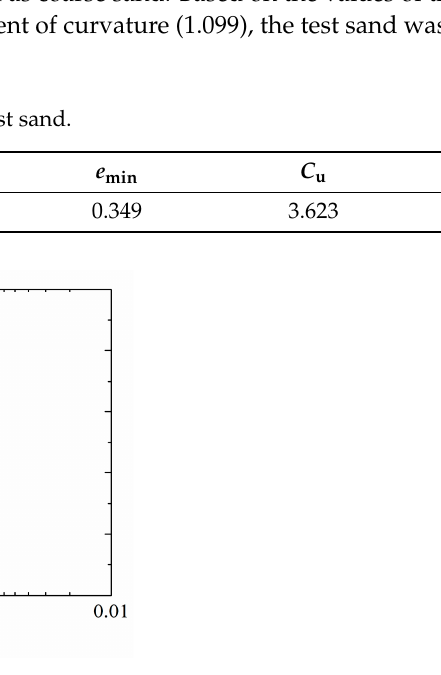
Figure 1. Particle-size distribution curve of the test sand.